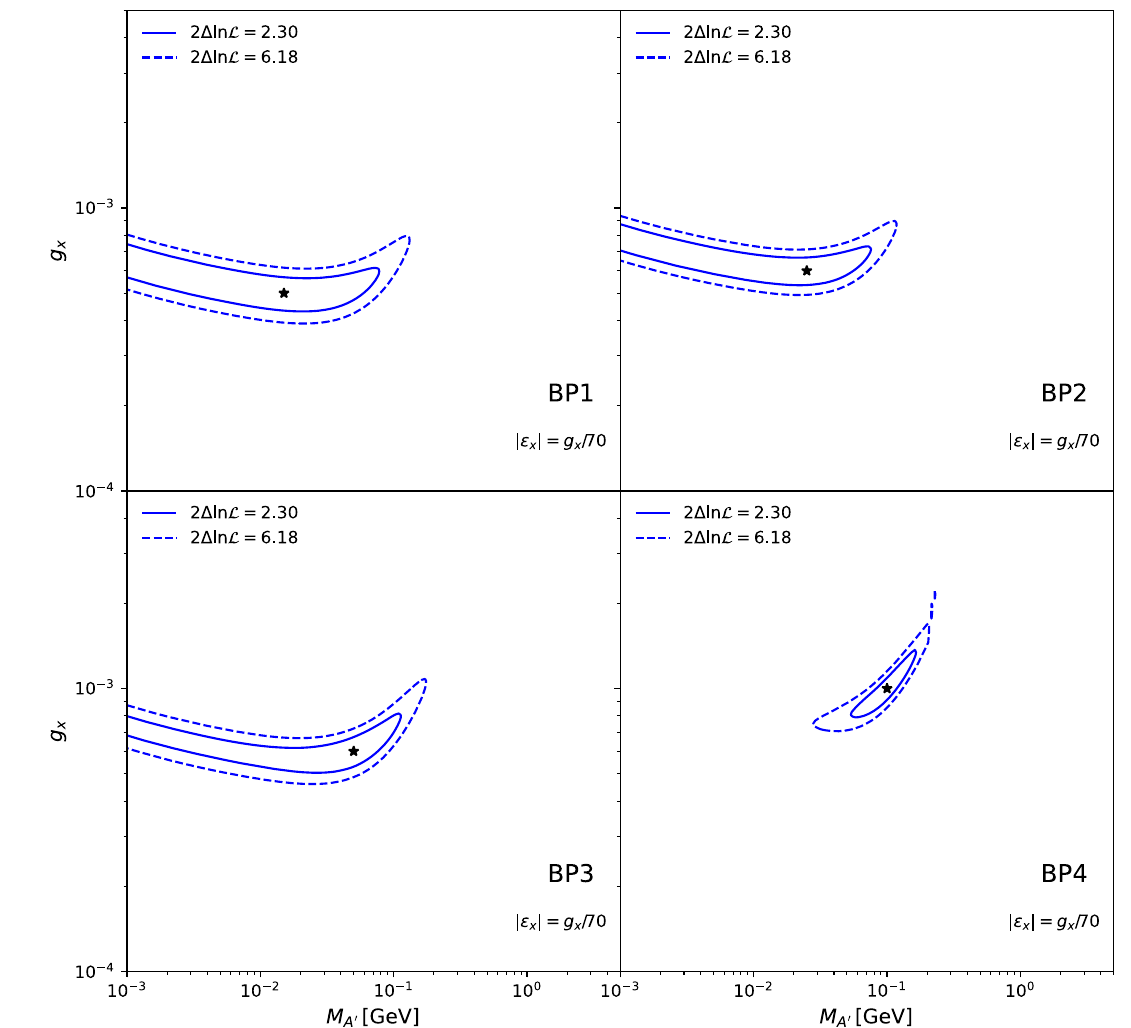
Fig. 5 Parameter reconstruction for each of the BPs of Table 1 at NA64 μ . The solid (dashed) contours correspond to the 68% CL (95% CL). The blue contours are the parameter reconstructions for a U ( 1 ) L μ